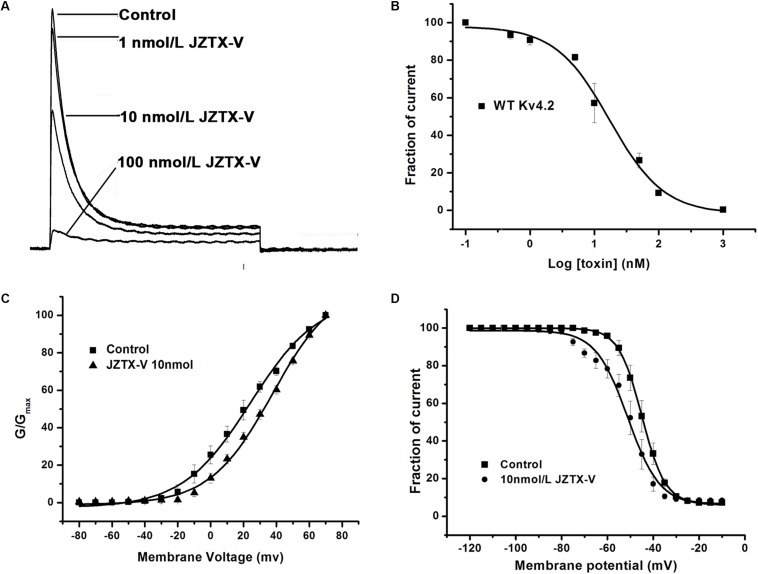
Effects of JZTX-V on WT Kv4.2-kchip2 expressed in HEK293T cells. (A) Kv4.2 current traces. Data are normalized to the maximum peak current amplitude. (B) The concentration-dependent inhibition of WT Kv4.2 channel by JZTX-V. Data points (mean±SE) were fit with the Hill equation as described under the Section “Materials and Methods.” (C,D) Effects of the JZTX-V on normalized steady-state activation and inactivation of WT Kv4.2.